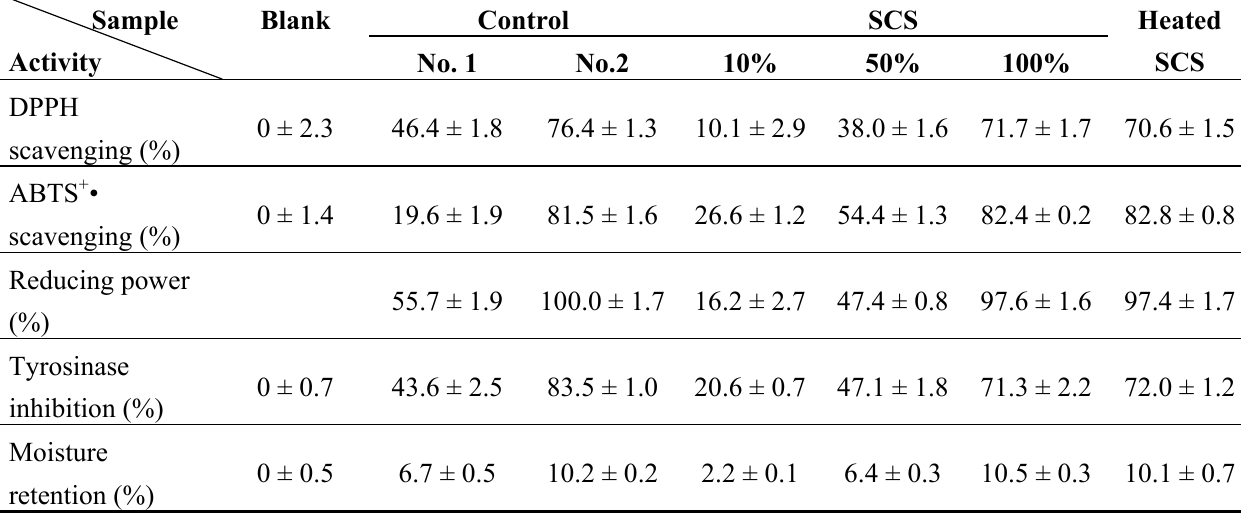
Table 1. Activities of Lactobacillus rhamnosus spent culture